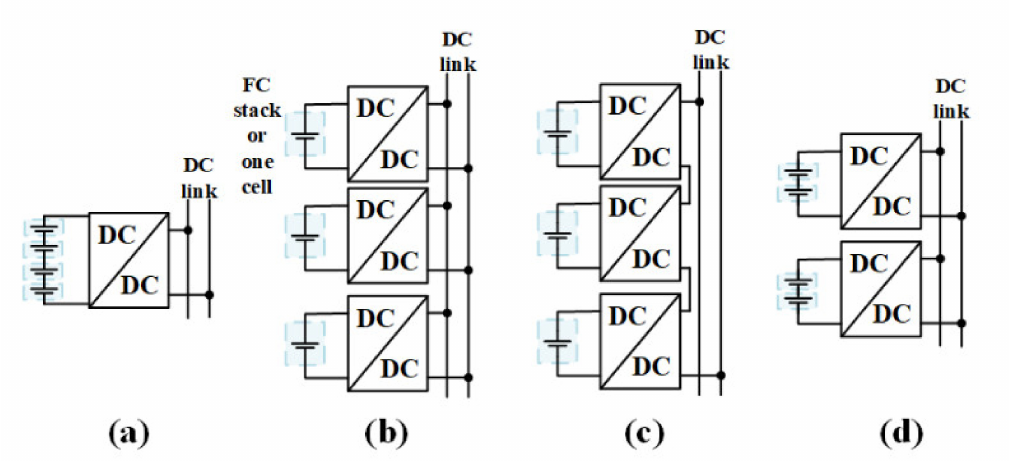
Figure 1. Multi stack topologies: ( a ) Series; ( b ) Parallel; ( c ) Cascade; ( d ) Series-parallel.